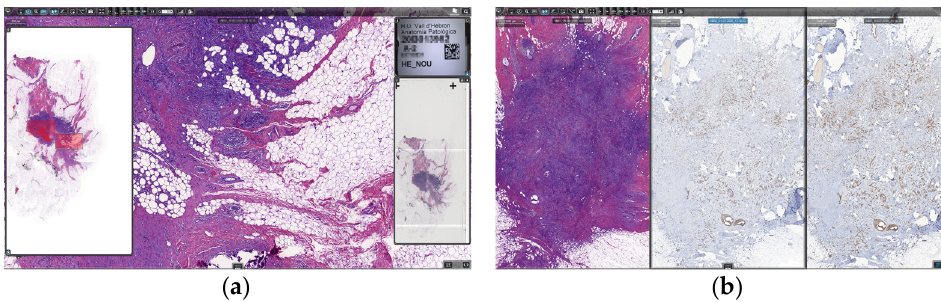
Figure 7. ClinicalViewer: ( a ) slide with navigation panel; and ( b ) three auto-aligned slides.